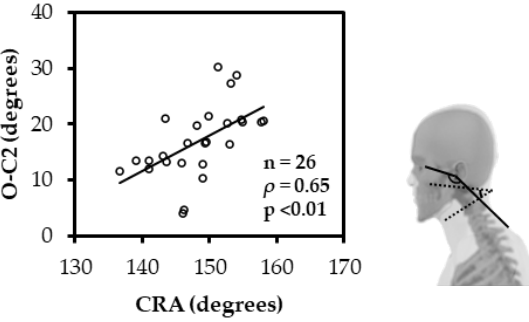
Figure 5. Spearman rank correlation between CRA and O-C2. The CRA and O-C2 showed a significant positive correlation. (CRA: cranial rotation angle; O-C2: occipito-C2 lordosis).